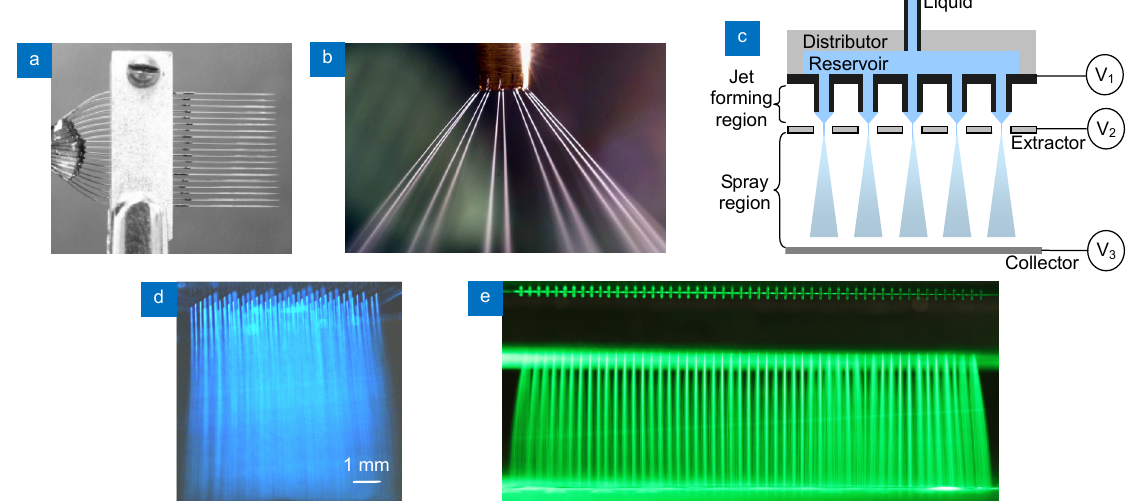
Fig. 4 | Three typical configurations of multiplexed electrosrpay . (a) Linear array of 19 silica capillaries 49 . (b) Multi-jet mode with 24 jets stabilized on the grooved nozzle 50 . (c) The three-electrode design 51 . (d) Planar array of silicon nozzles 51 . (e) CNC micromachined linear array made of brass 42